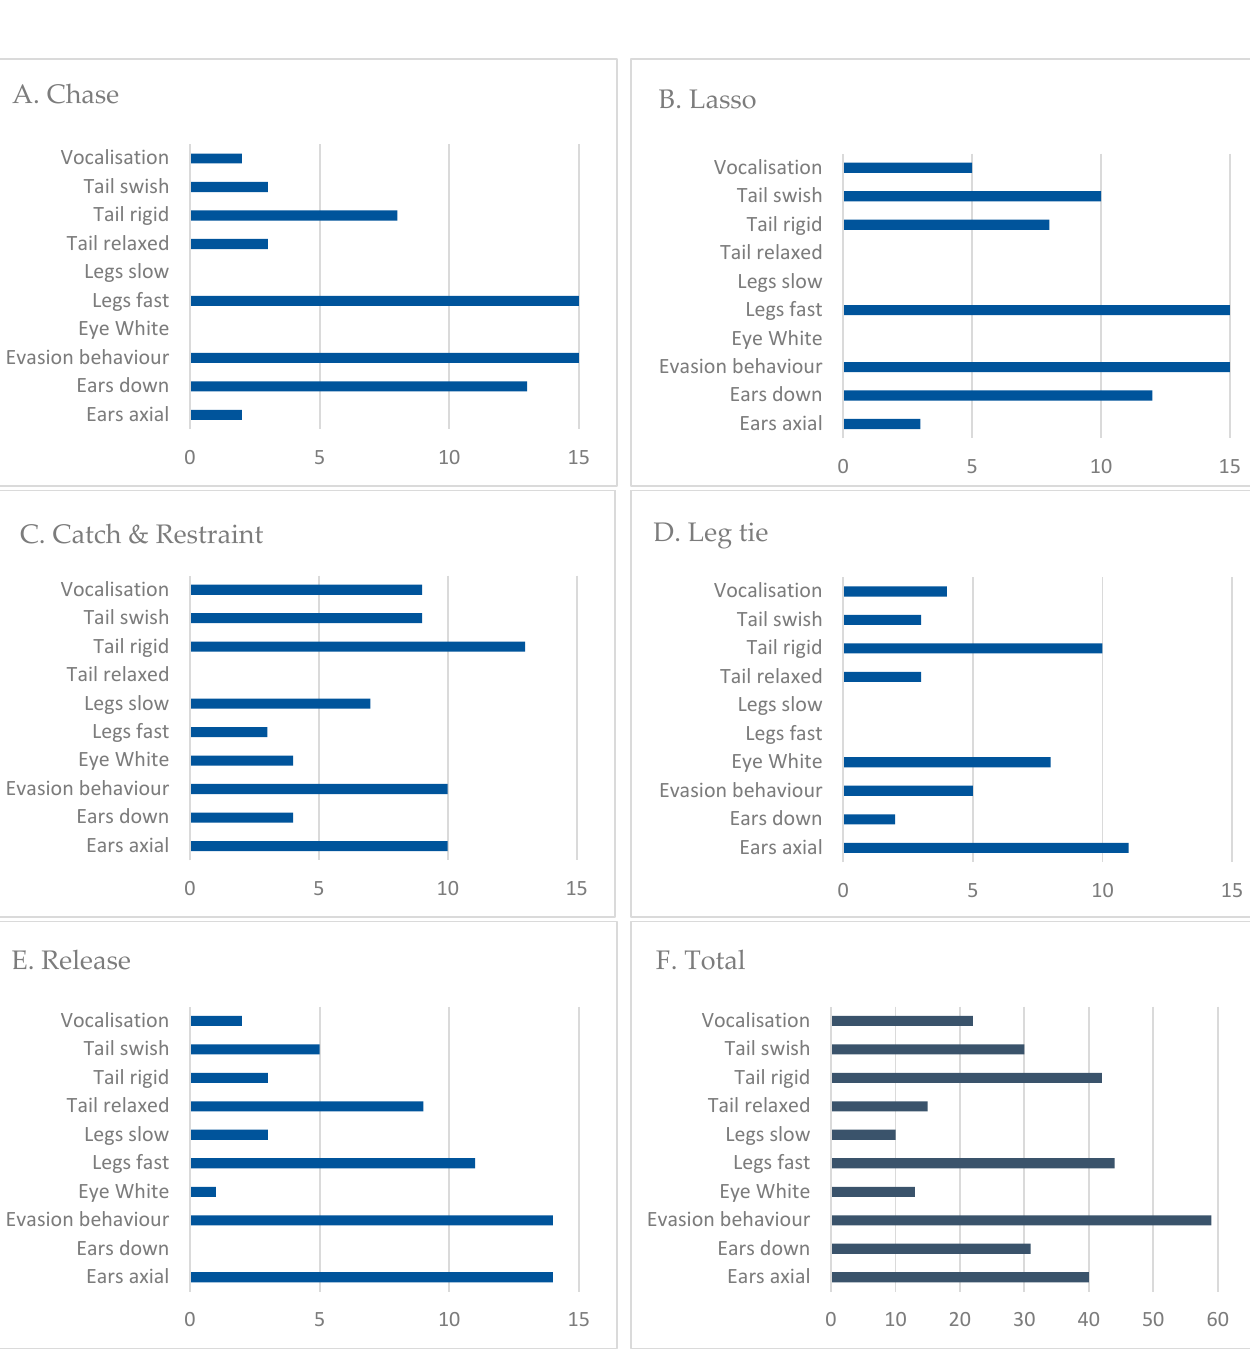
Figure 1. Column graphs ( A – F ) display the cross-tabulation results of the behaviours expressed by calves ( n = 15) in calf roping events. Each graph represents one phase of the event ( A – E ), and graph ( F ) displays the total number of behaviours expressed by calves across the phases of